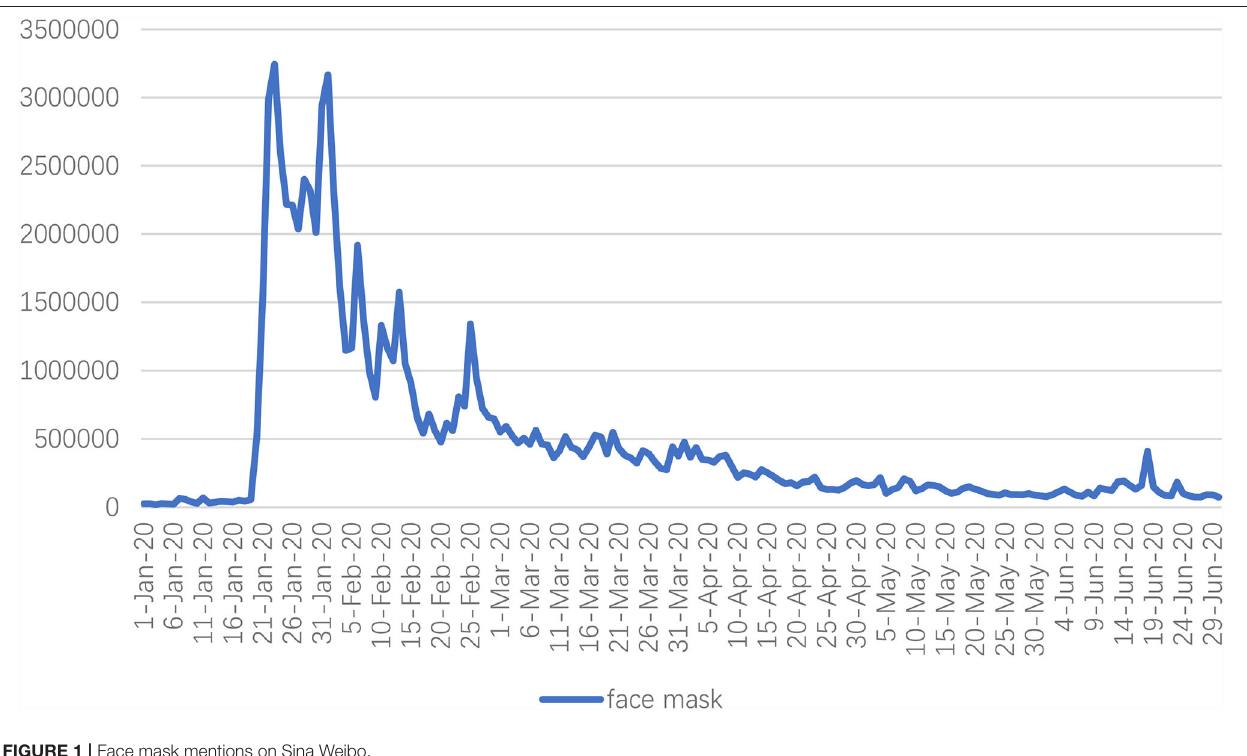
FIGURE 1 | Face mask mentions on Sina Weibo.